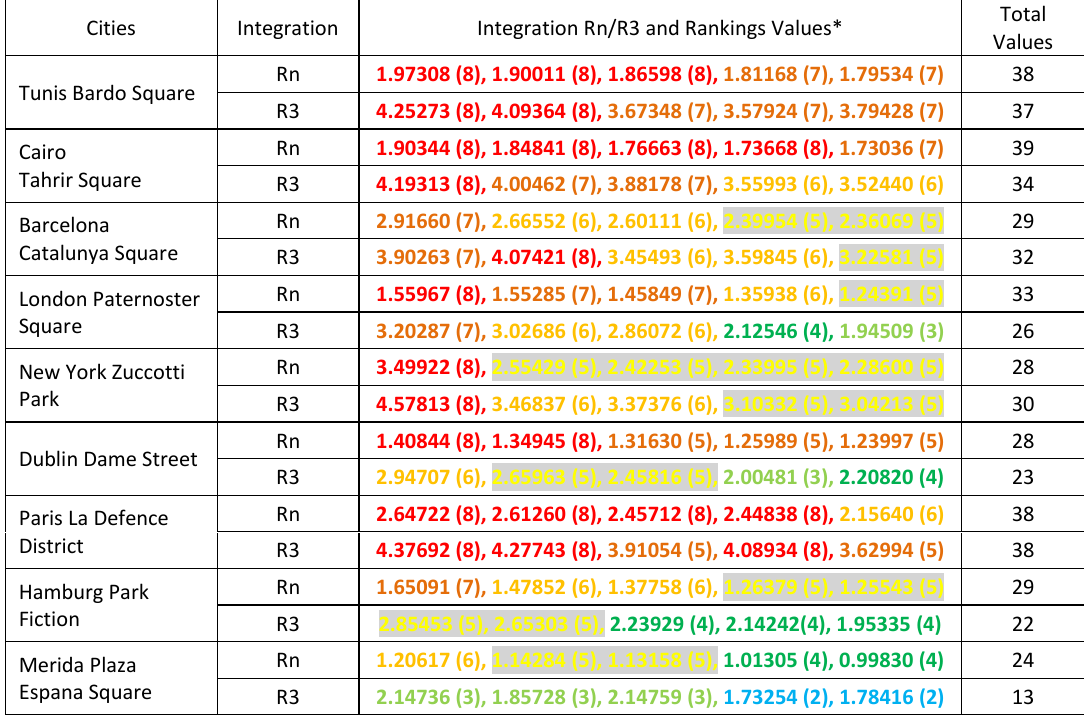
*Colors are retrieved from the Space Syntax software. They represent the ranking of the integration values within the whole